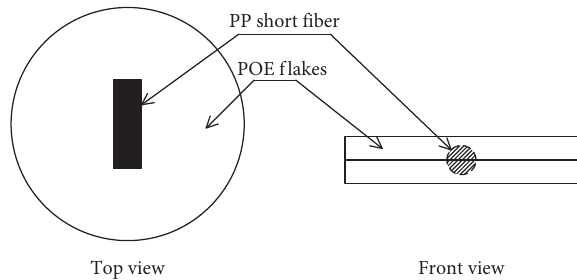
Figure 8: Illustration of the experimental sample prepared for interfacial tension